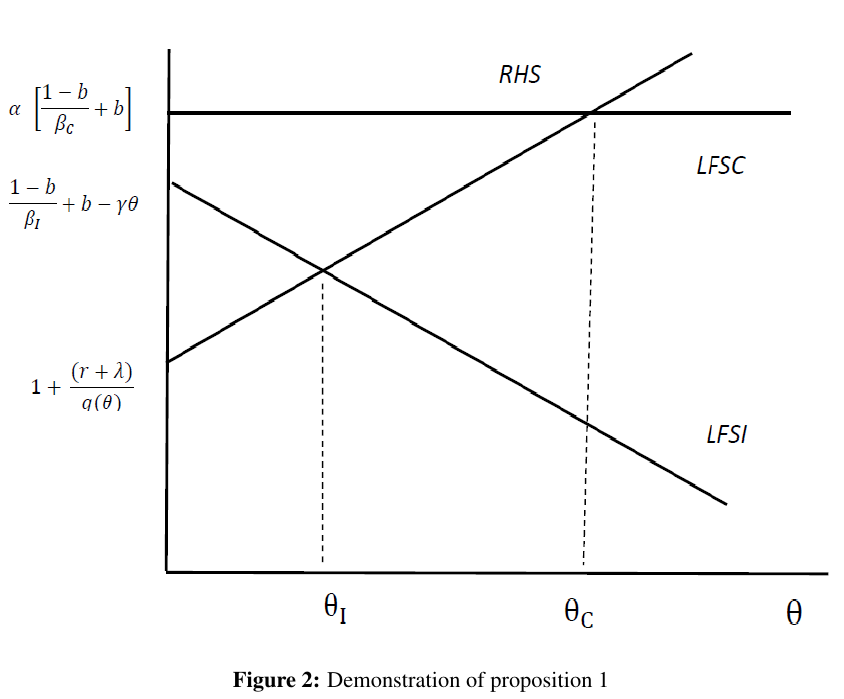
Figure 1: Demonstration of proposition 1